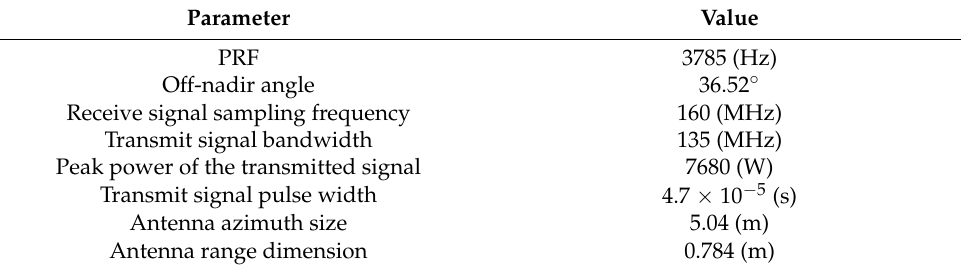
Table 3. Signal and antenna